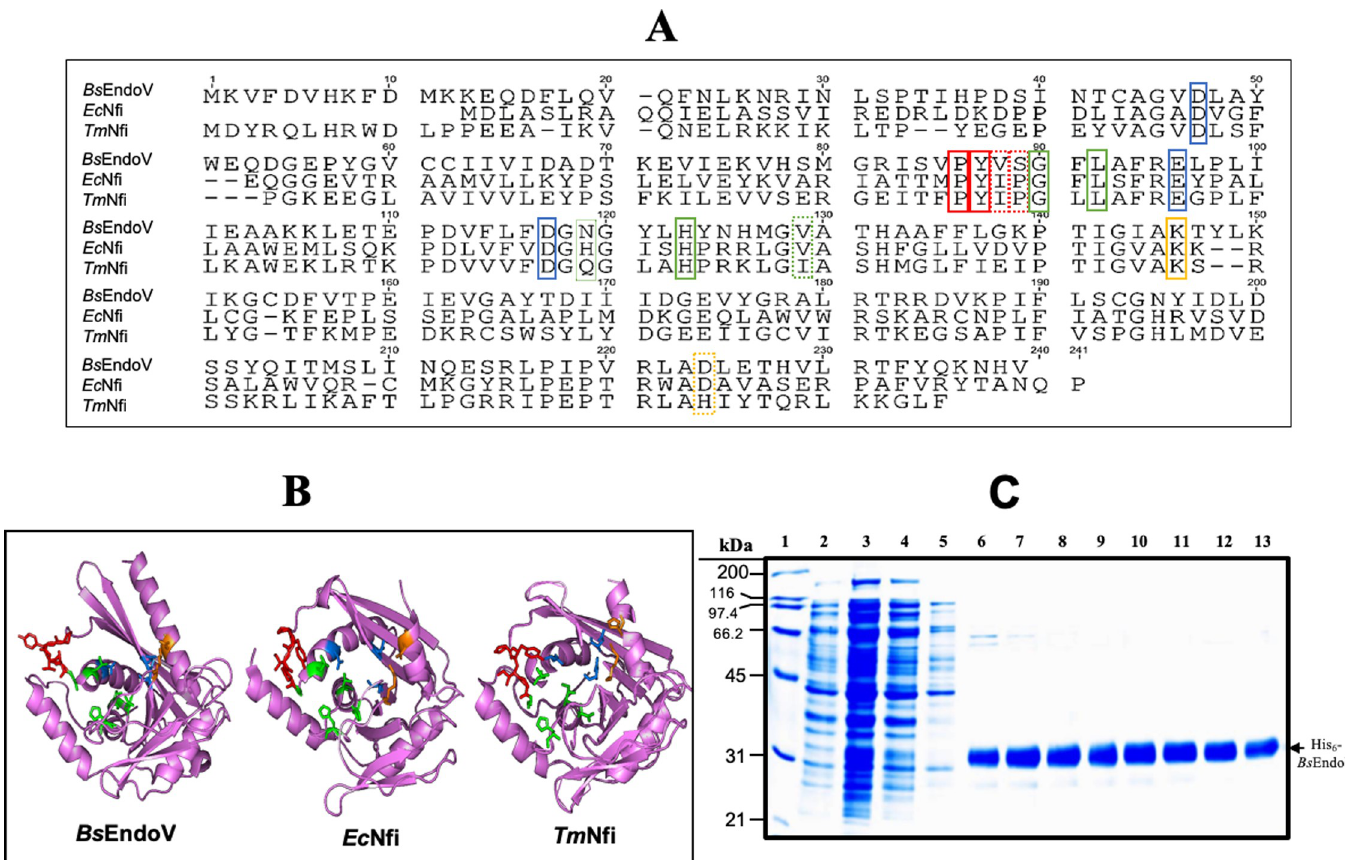
Fig 1. Comparison of different Endonuclease Vs and purification of Bs EndoV. (A) Amino acid sequence alignment of Bs EndoV with homologs from E . coli (Nfi) and T . maritima (Nfi). Identical residues involved in activity between enzymes are enclosed with solid lines; dissimilar residues are enclosed with dashed lines. Colors of amino acids denote: red—residues comprising the insertional wedge to stabilize flipping-out of Hx; green—residues involved in the damaged-base recognition pocket; blue— residues that bind Mg 2+ necessary for endonucleolytic action; and orange—residues involved in forming the post-incision complex. (B) Tertiary structures (magenta) of EndoV homologs from B . subtilis , E . coli and T . maritima ; PDB accession numbers 3HD0, 3GA2 and 4XPU, respectively. Amino acids involved in recognition, catalysis, and complex formation are depicted as sticks with the same color code as in (A). (C) SDS-PAGE analysis of Bs EndoV induction and purification by IMAC, all as described in Methods. Lane 1, molecular weight markers; lane 2, cell lysate of non-induced E . coli PERM1071 strain; lane 3, IPTG-induced extract of E . coli PERM1071; lane 4, flowthrough; lane 5, wash fraction and lanes 6 to 13, protein eluted from the Ni-NTA column with 250 mM imidazole. The purified protein from fraction 13 was employed for the DNA repair assays.